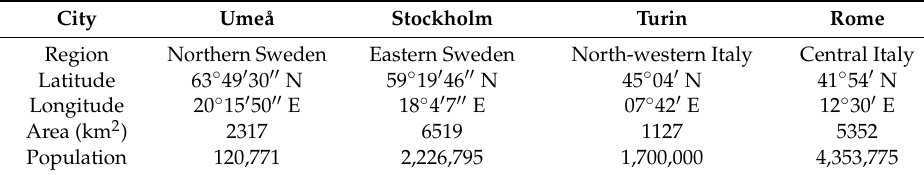
Table 1. Name and specifics of the selected locations.